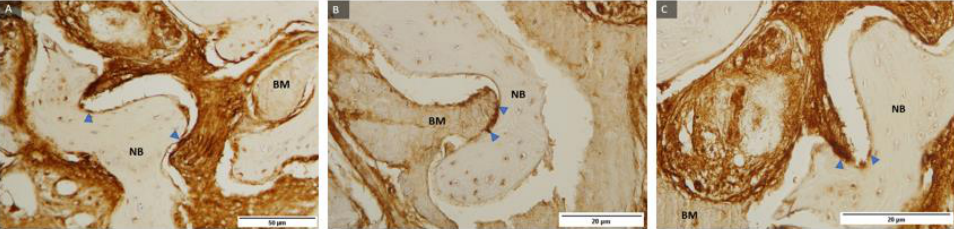
Figure 6. Examples of preparations of the test group ( A – C ) and immunohistochemical Osx staining of bone sections after implantation of transcription factor Osx with labelling of newly formed bone (NB), residual biomaterial (BM), and cells with a strength of 3 (+++) expression of Osx (blue marked triangle). 100, 200, and 400× magnification.